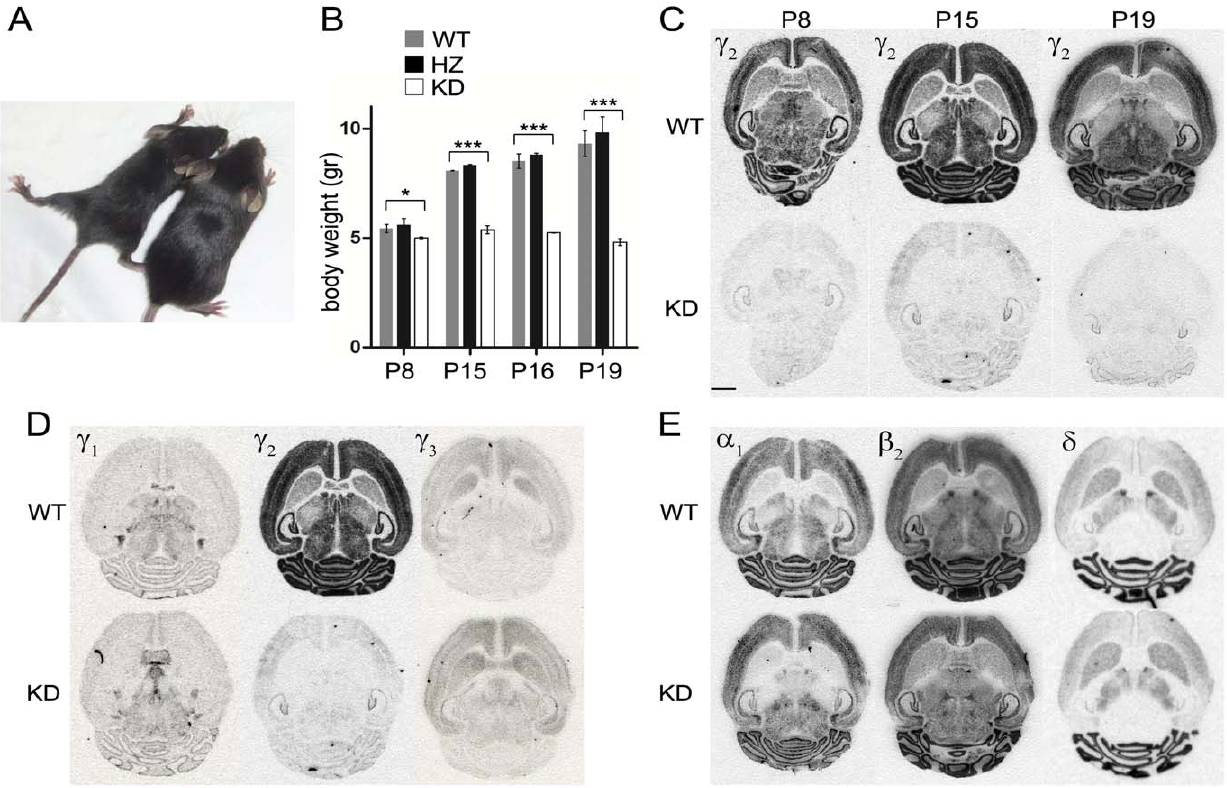
Figure 2. Phenotype of c 2 KD mice and reduced expression of the c 2 subunit gene. A, Reduced growth of a P18 c 2 KD mouse (left) compared to a WT littermate. Note also the atypical posture of the mutant mouse. B, Bodyweight table of WT, heterozygous (HZ) and homozygous (KD) c 2 KD mice (***, p , 0.0001; *, p=0.0198; unpaired t -test; n=3 mice per group). C–E, In situ hybridization on horizontal brain sections from WT and c 2 KD mice. Note the very low expression levels of the c 2 subunit in developing brains homozygous for the c 2 I77 cDNA insertion into the gabrag2 gene ( C ), whereas no obvious change is visible in the expression of the other c isoforms ( D ) and of other GABA A R subunits ( E ). The sections in D,E are from P15 mice. Scale bar: 2 mm.